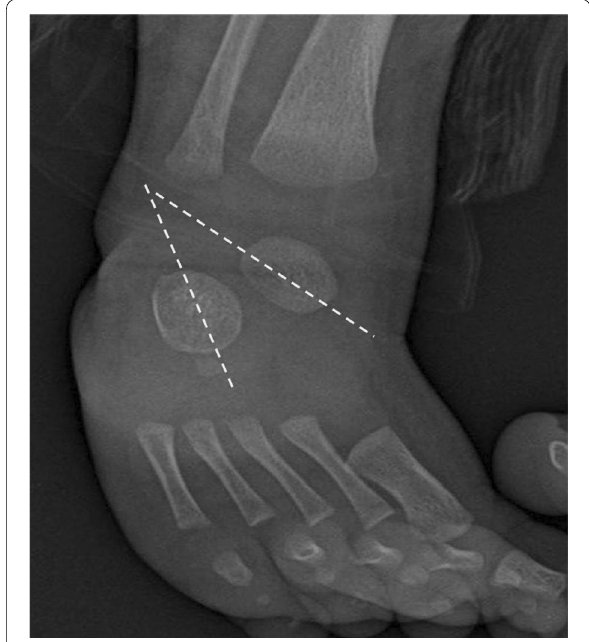
Fig. 10 Plain X-ray AP view of the of the left foot for a 23-day-old male baby, presenting with vertical talus, showing increased talocalcaneal angle